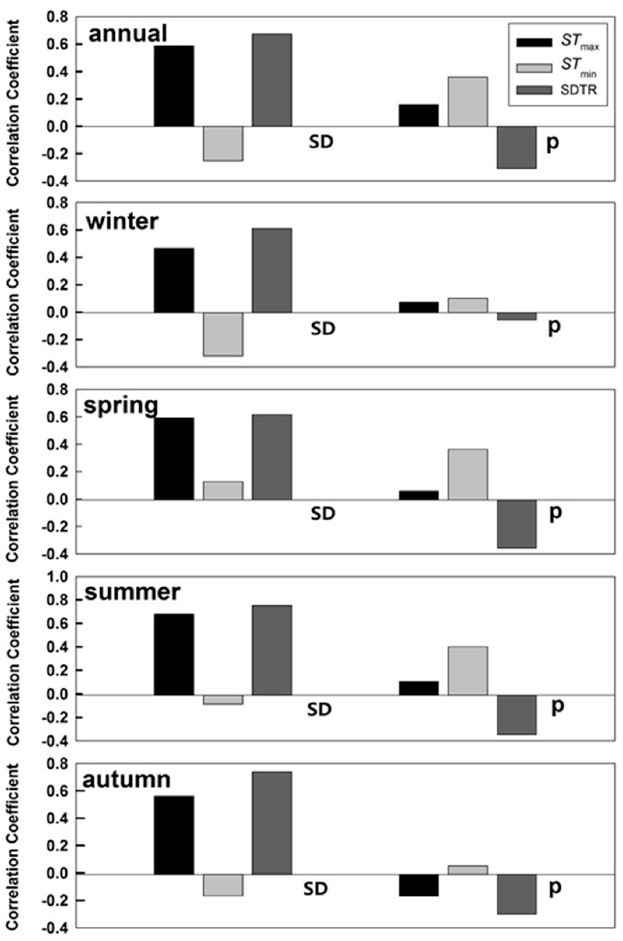
Figure 5. Partial correlation coe ffi cients between ST max , ST min , SDTR, and sunshine duration (SD), precipitation (p) on annual and seasonal scales in China during 1962–2011. All the correlation coe ffi cients were significant ( p < 0.05).